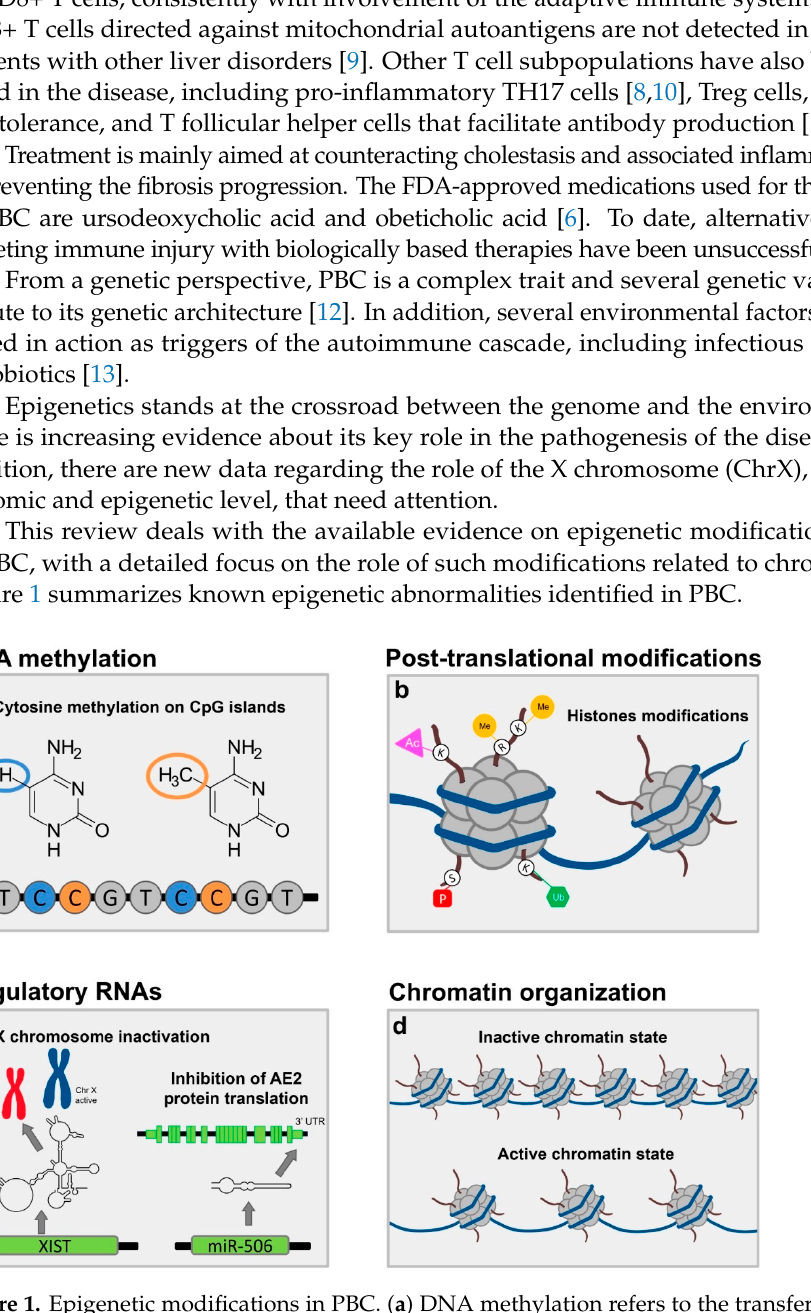
Figure 1. Epigenetic modifications in PBC. ( a ) DNA methylation refers to the transfer of a methyl group onto the C5 position of the cytosine to form 5-methylcytosine in CpG sites, and typically, it induces gene silencing. In PBC cases, a significantly reduction in methylation level of CD40L and CXCR3 promoters was observed in CD4+ cells, resulting in a higher expression of these genes. ( b ) Histone modifications, e.g., acetylation, are post-translational modifications that affect histones and impact their interaction with DNA. PBC patients have high expression levels of β arr1 in T lymphocytes, which controls acetylation of histone H4 in the promoter regions of several genes ( CD40L